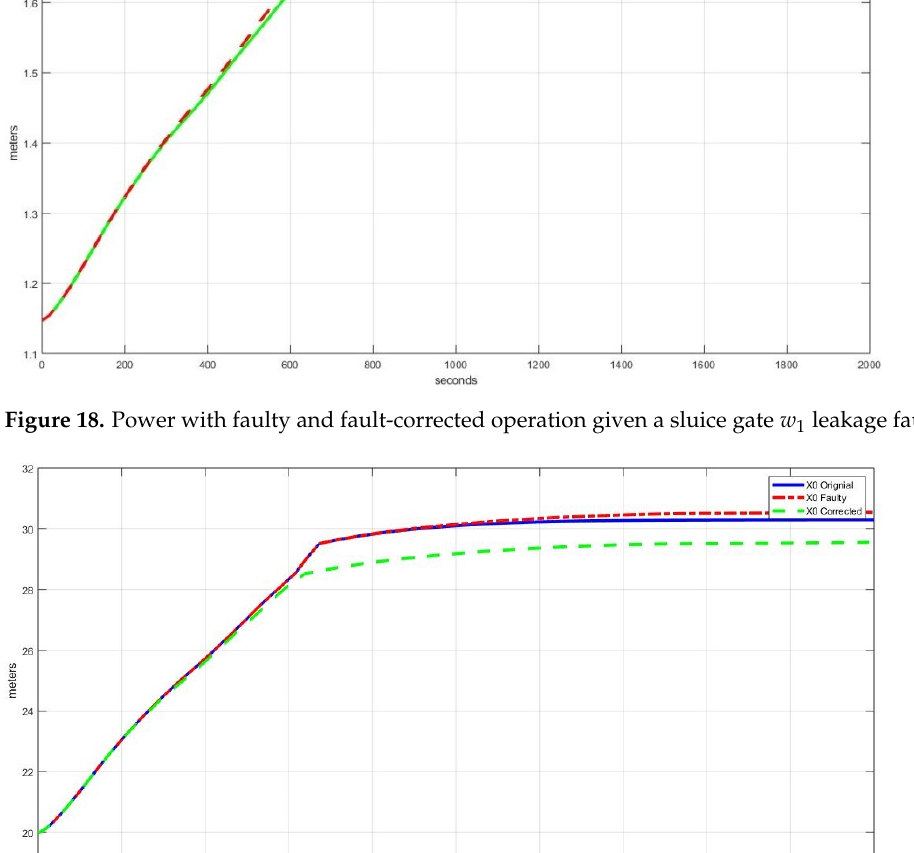
Figure 19. Pond 0 with normal, faulty, and fault-corrected operation given a sluice gate w 1 leakage fault.